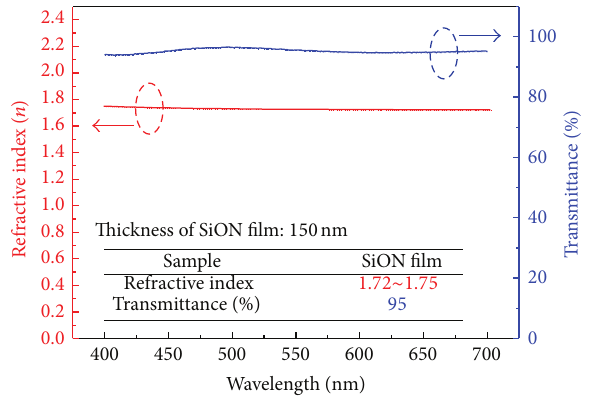
Figure 2: Measured transmittance and refractive index of SiON film (150nm in